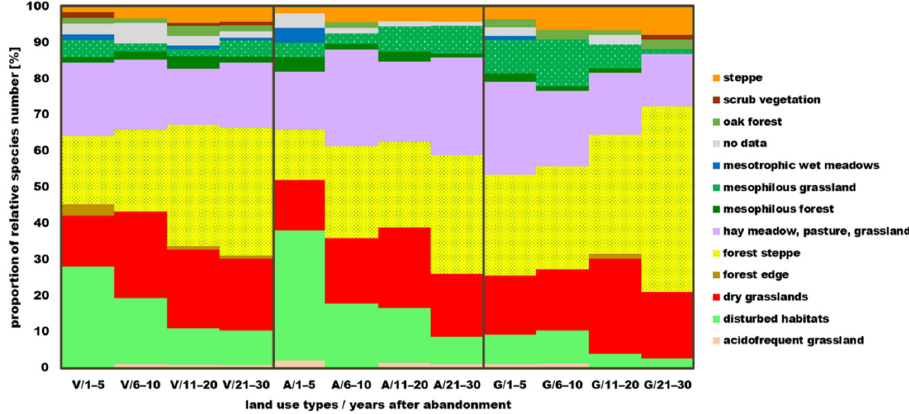
Figure 5. Distribution of the relative species number of habitat category in different age groups of abandoned lands (V—vineyards, A—arable land, G—grasslands).